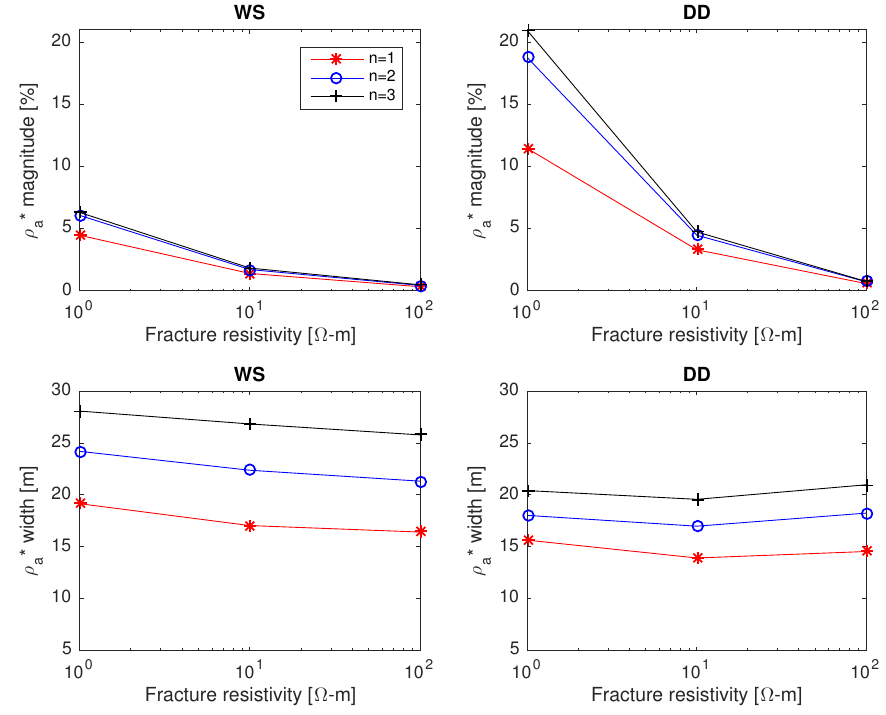
Figure 8. Apparent resistivity anomaly magnitude and width as a function of fracture resistivity for the case of a single, 1-mm-aperture fracture having length (cid:96) = 5 m and dipping at 45 ◦ . The fracture is hosted in bedrock having electrical resistivity ρ b = 10,000 Ω · m, whereas the overburden resistivity is ρ o = 1000 Ω · m. The overburden thickness is 1 m. The measurement configuration is denoted by WS (Wenner-Schlumberger) or DD (dipole-dipole) with spacing factor n . Cases 2, 15, and 16 from Table 1 are